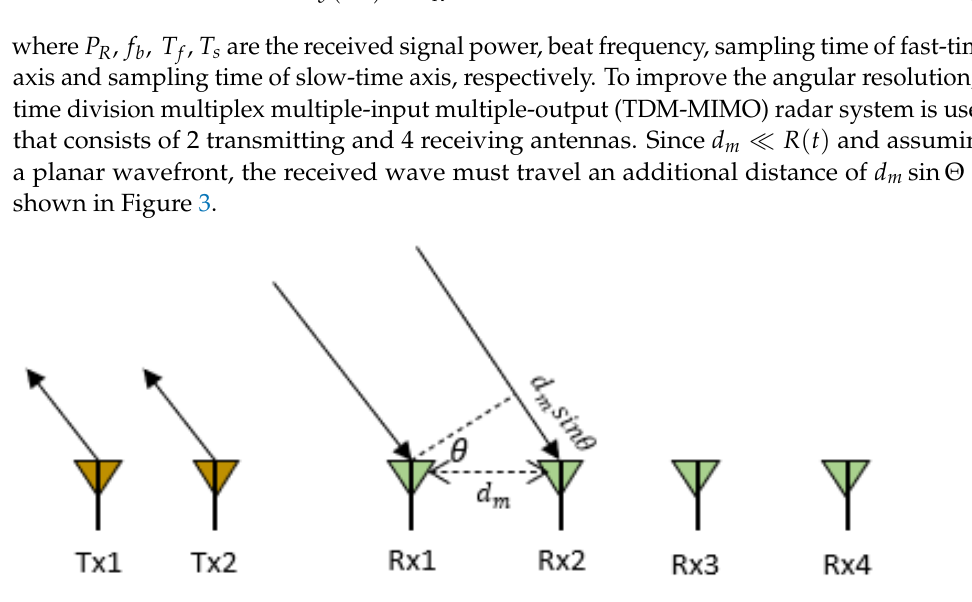
Figure 3. A MIMO radar with two transmitting antennas (Tx) and four receiving antennas (Rx) where distance between two receiving antennas is d m and θ is the angle of